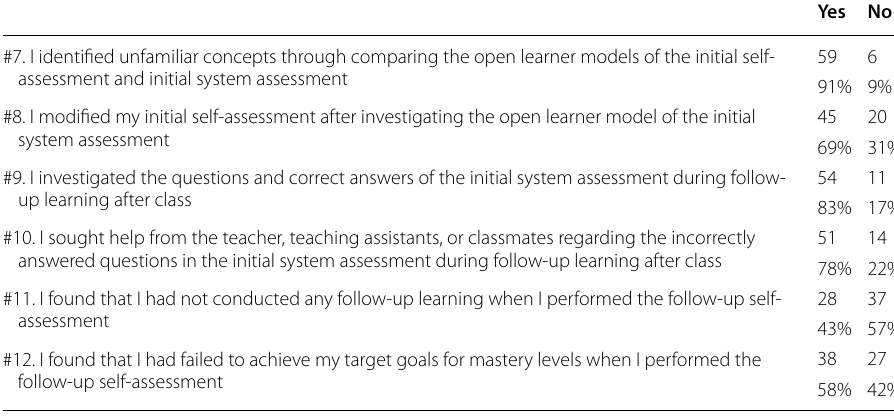
Table 14 Results of part 2 of the